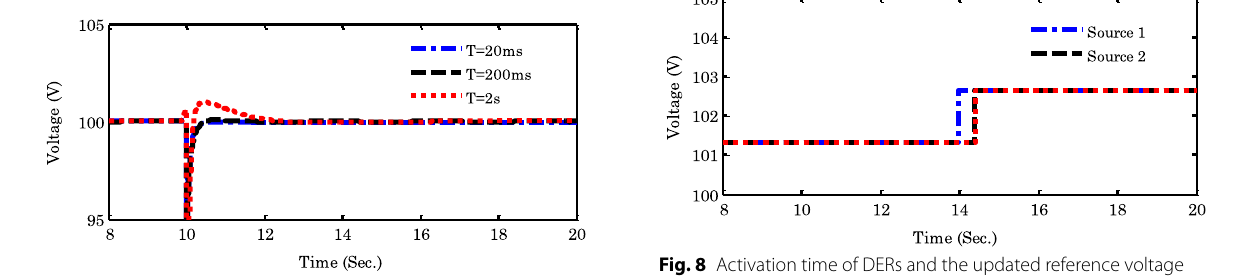
Fig. 7 Effect of communication delay on load voltage